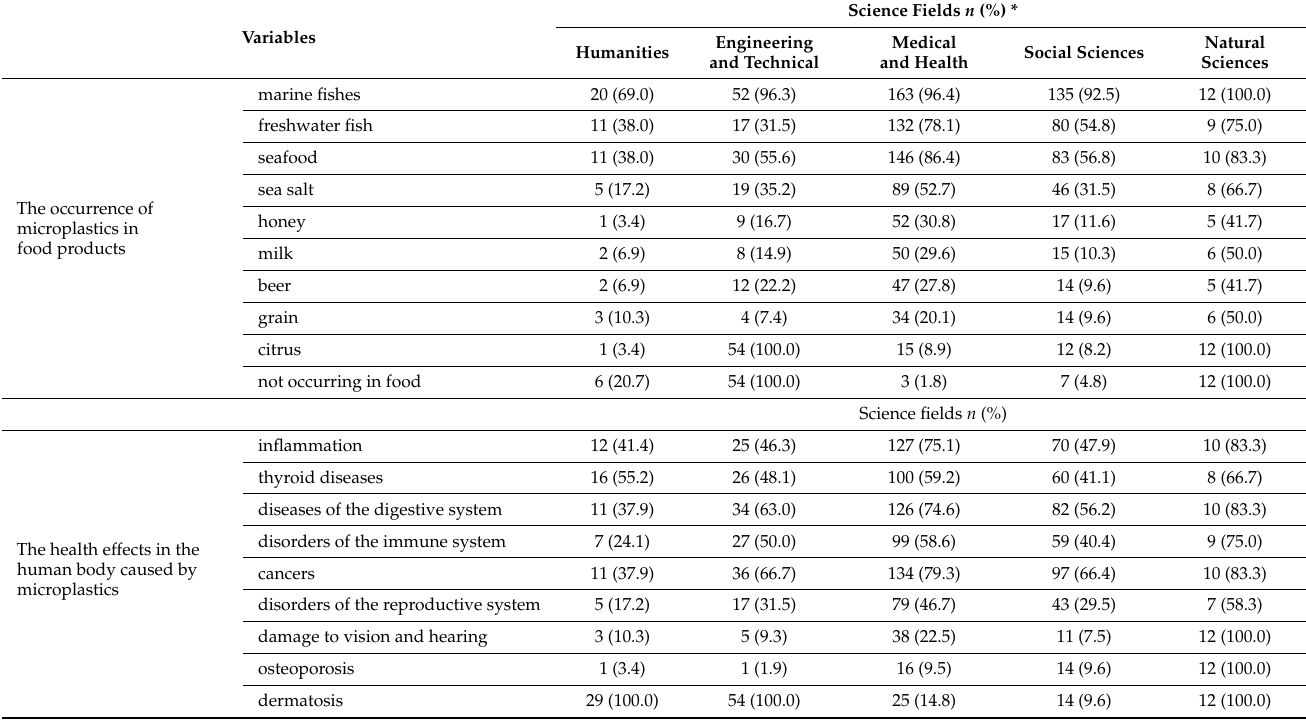
Table 3. The state of respondents’ knowledge about the occurrence of microplastics in food products and the health effects in the human body caused by